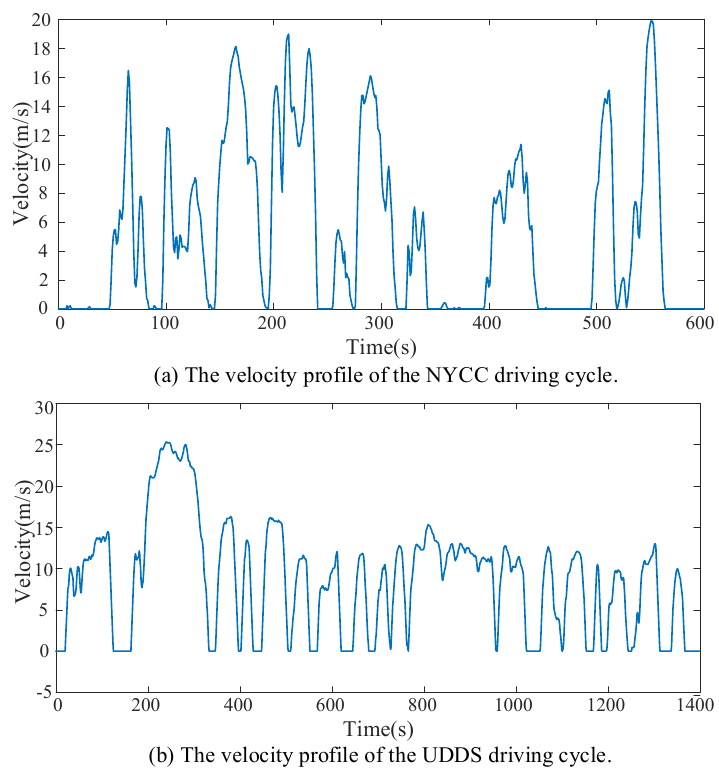
Figure 6. The NYCC driving cycle and the UDDS driving